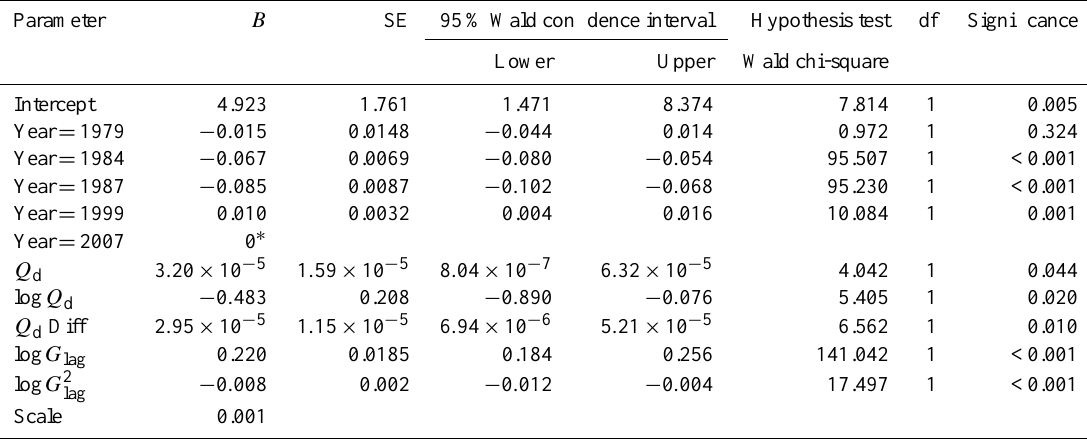
Table 1. Parameter estimates and goodness of fit.